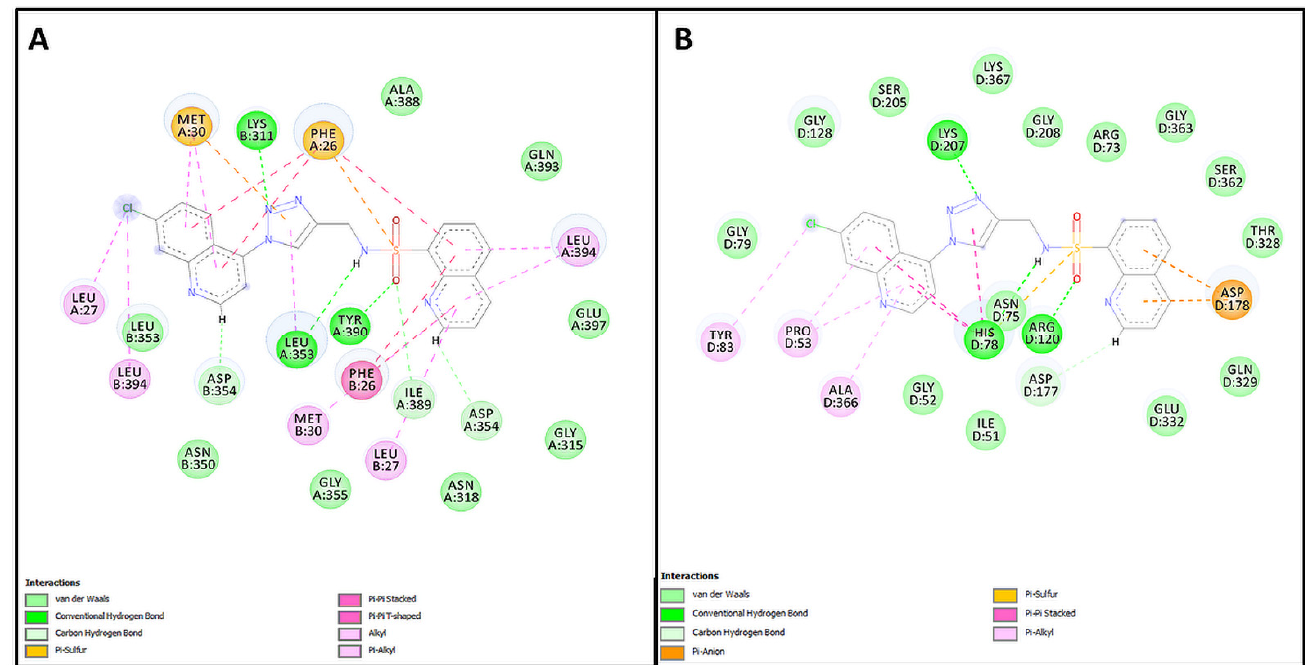
Figure 4. 2D representation of docked molecule 9a and its interactions on the active site of PKM2 (( A ): PDB ID 4G1N, ( B ): PDB ID 4FXF).